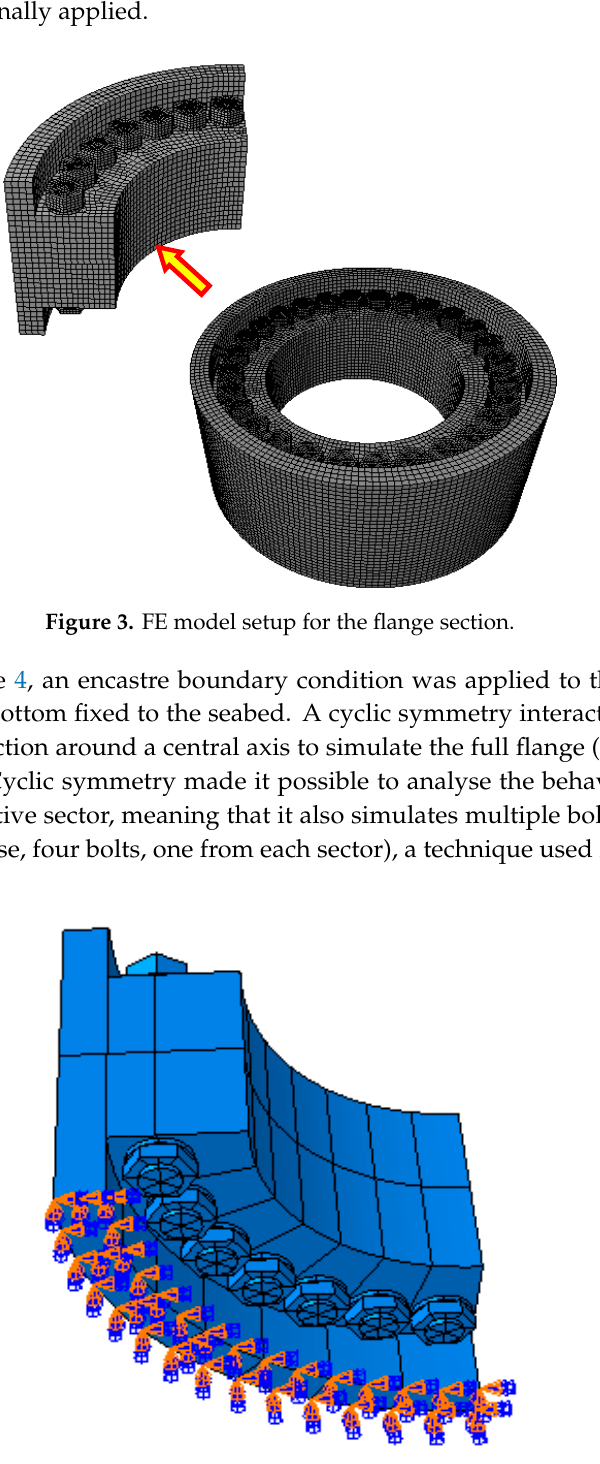
Figure 4. Boundary conditions in the FE model .